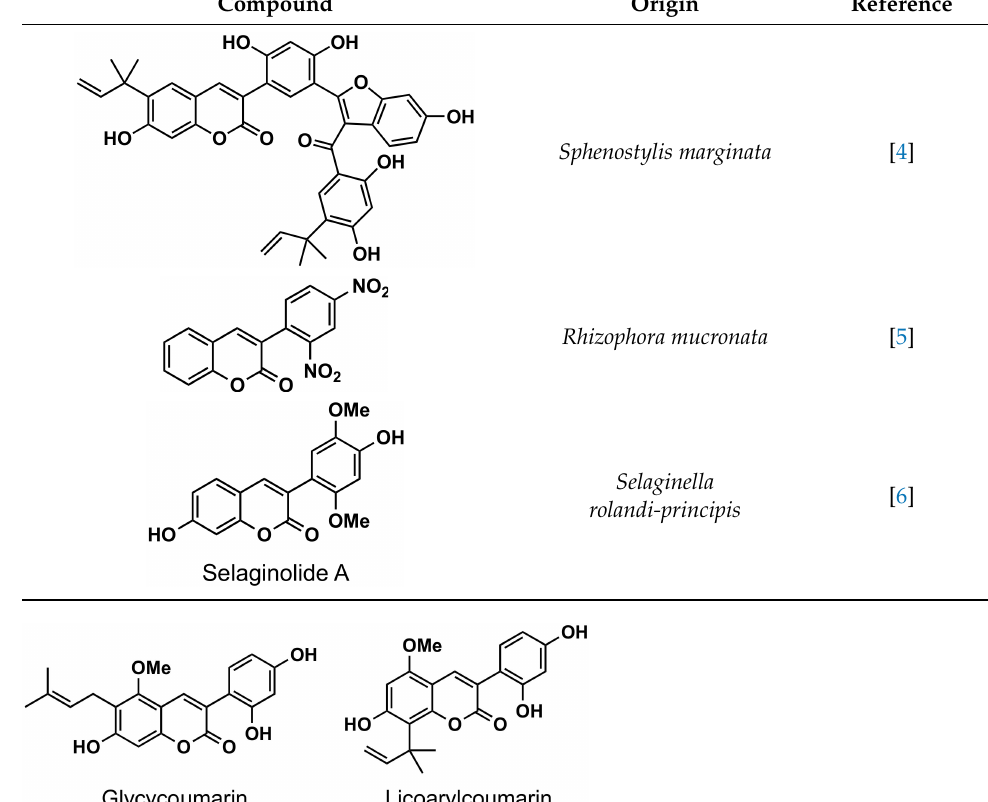
Figure 2. Chemical structures of glycycoumarin and